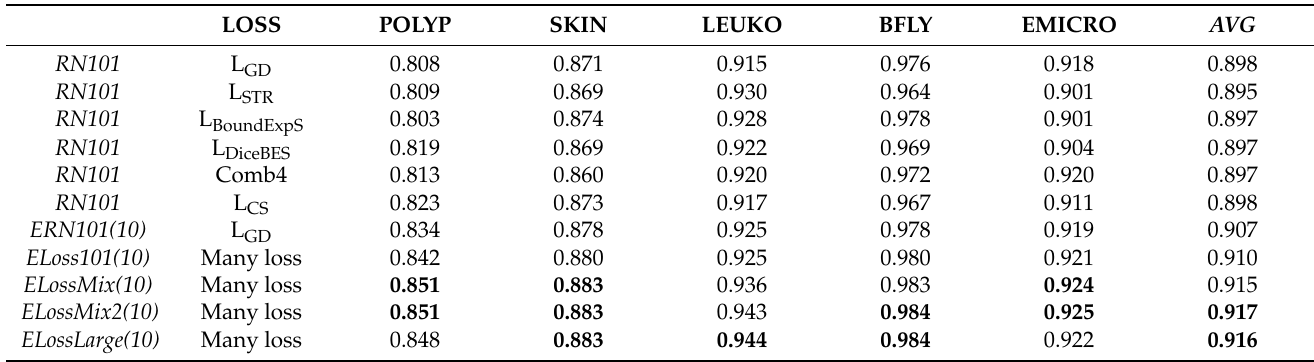
Table 3. Performance (dice) of some stand-alone methods and ensembles in the five benchmark datasets when varying the loss function; the last column AVG reports the average performance. Best performance is marked in bold font.